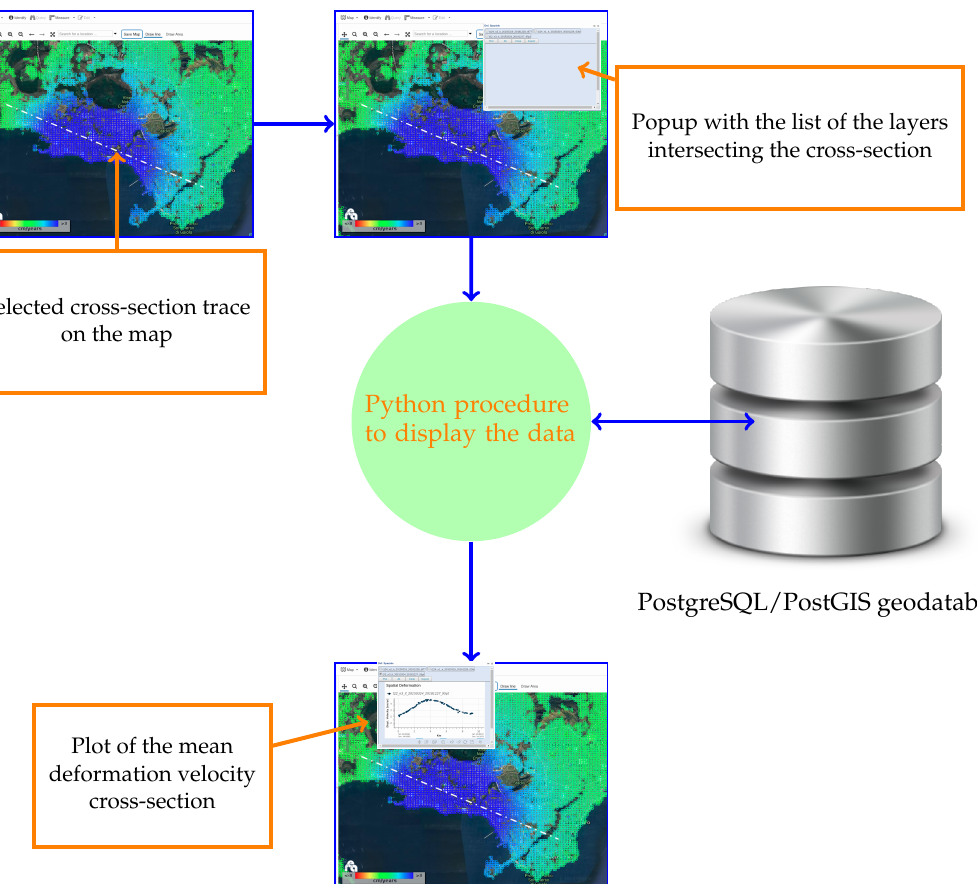
Figure 10. Flow chart of the mean deformation velocity cross-section plotting